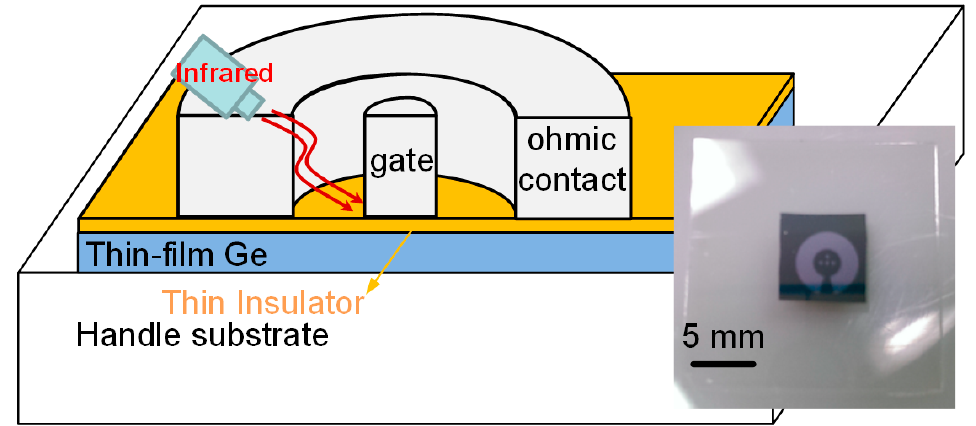
Figure 1. The schematic structure of a thin-film Ge photodetector. The inset shows the top-view of a photograph of a Ge-on-glass photodetector. The infrared output from fiber irradiates the edge of the gate electrode.